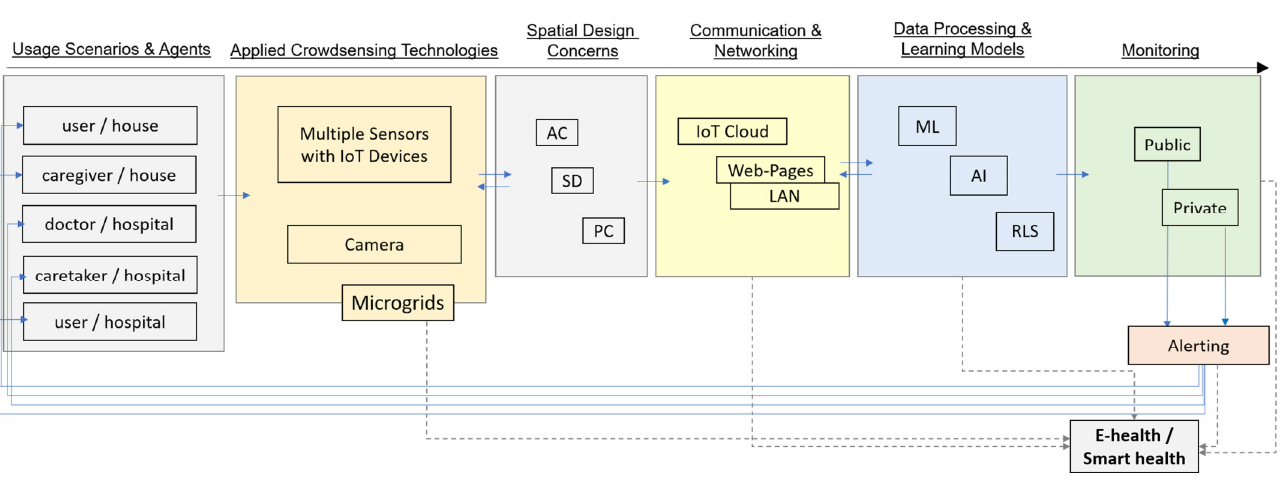
Figure 12. The potential scope of the research with regard to the Smart Health Services.